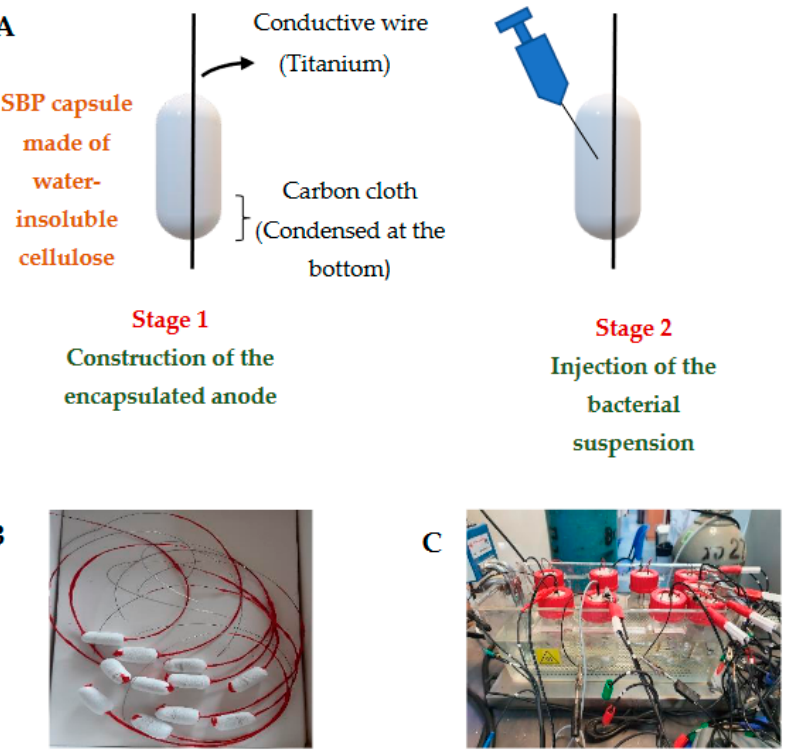
Figure 1. MEC based on the SBP anode. Scheme of the encapsulation anode preparation ( A ); Photo of the anode ( B ); MEC facilities with the encapsulated anode, based on the SBP technology ( C